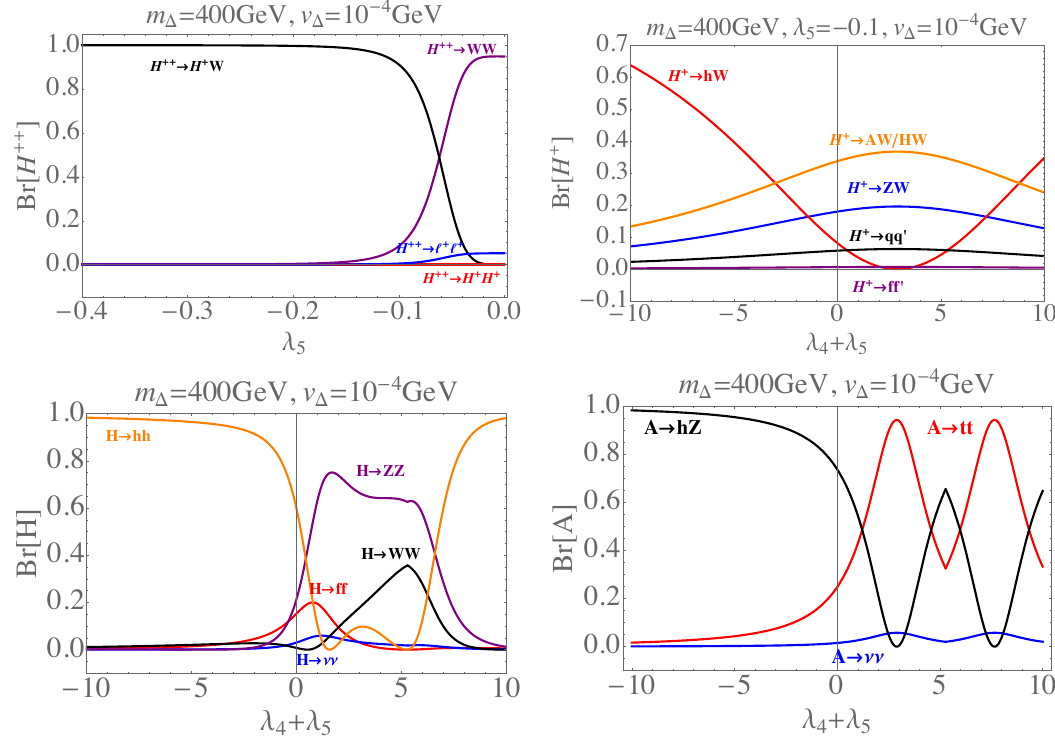
Figure 4 . Decay BRs for H , A , H (cid:6)(cid:6) and H (cid:6) as a function of (cid:21) 4 and (cid:21) 5 for representative values of m (cid:1) = 400 GeV and v (cid:1) = 10 (cid:0) 4 GeV. For a detailed discussion on the decay features, one can refer to the main text in section